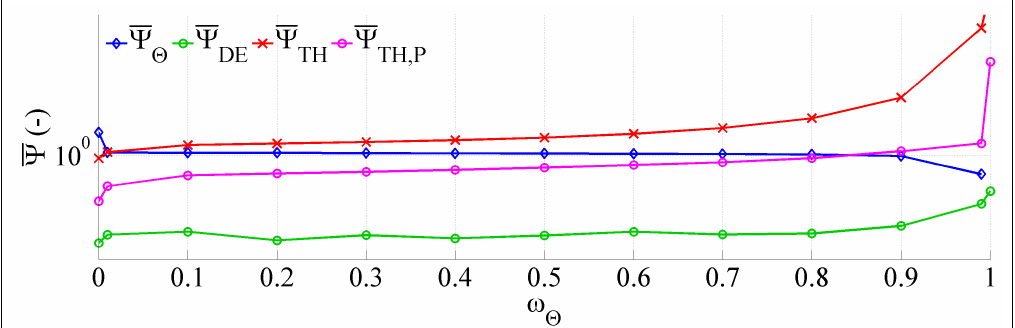
Figure 12. The criteria function member values as the function of ω Θ